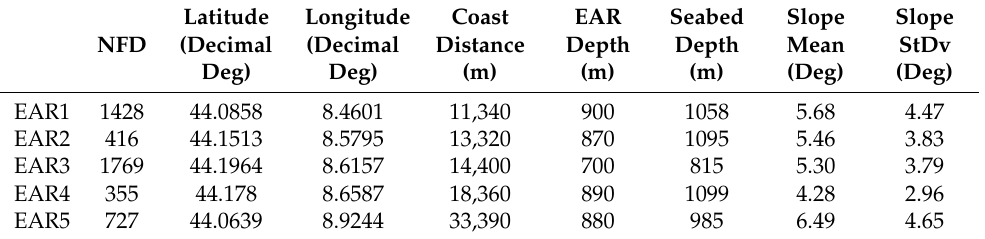
Table 2. Number of files with detection (NFD), geographic coordinates (latitude and longitude), and geomorphological variables (distance from the coast, depth, and slope) computed for every EAR inside buffer rings of 5000 m.